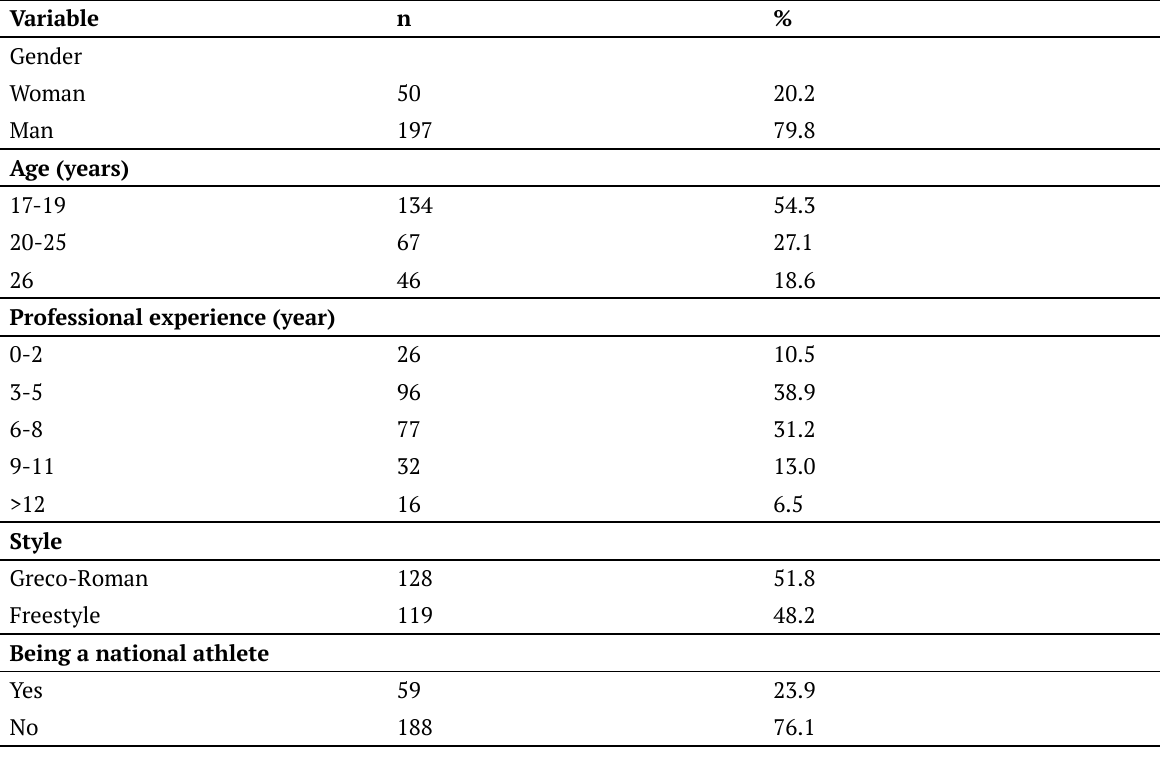
Table 1. Sociodemographic Characteristics